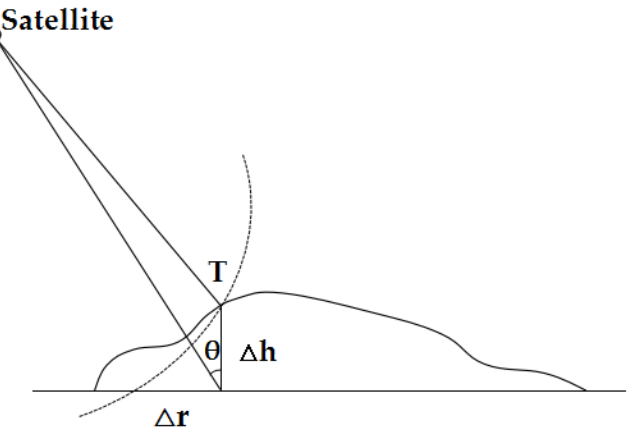
Figure 1. Geo-positioning error caused by the target elevation